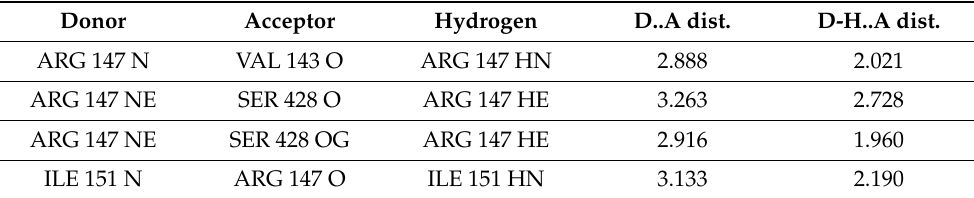
Table 2. Hydrogen bonds of Arg 147 in the His147Arg CCT5 variant ATP bound. Constraints relaxed by 0.4 angstroms and 20 degrees 1 .